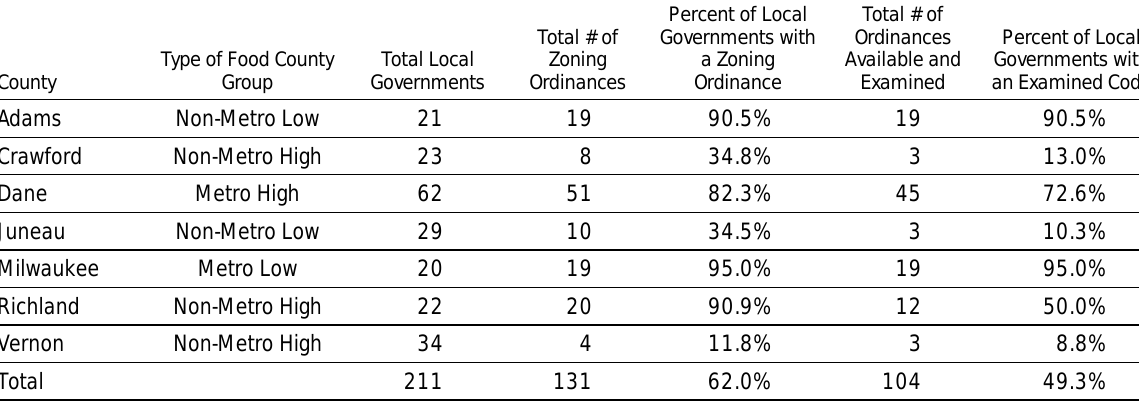
Table 1. Sample of Local Governments and